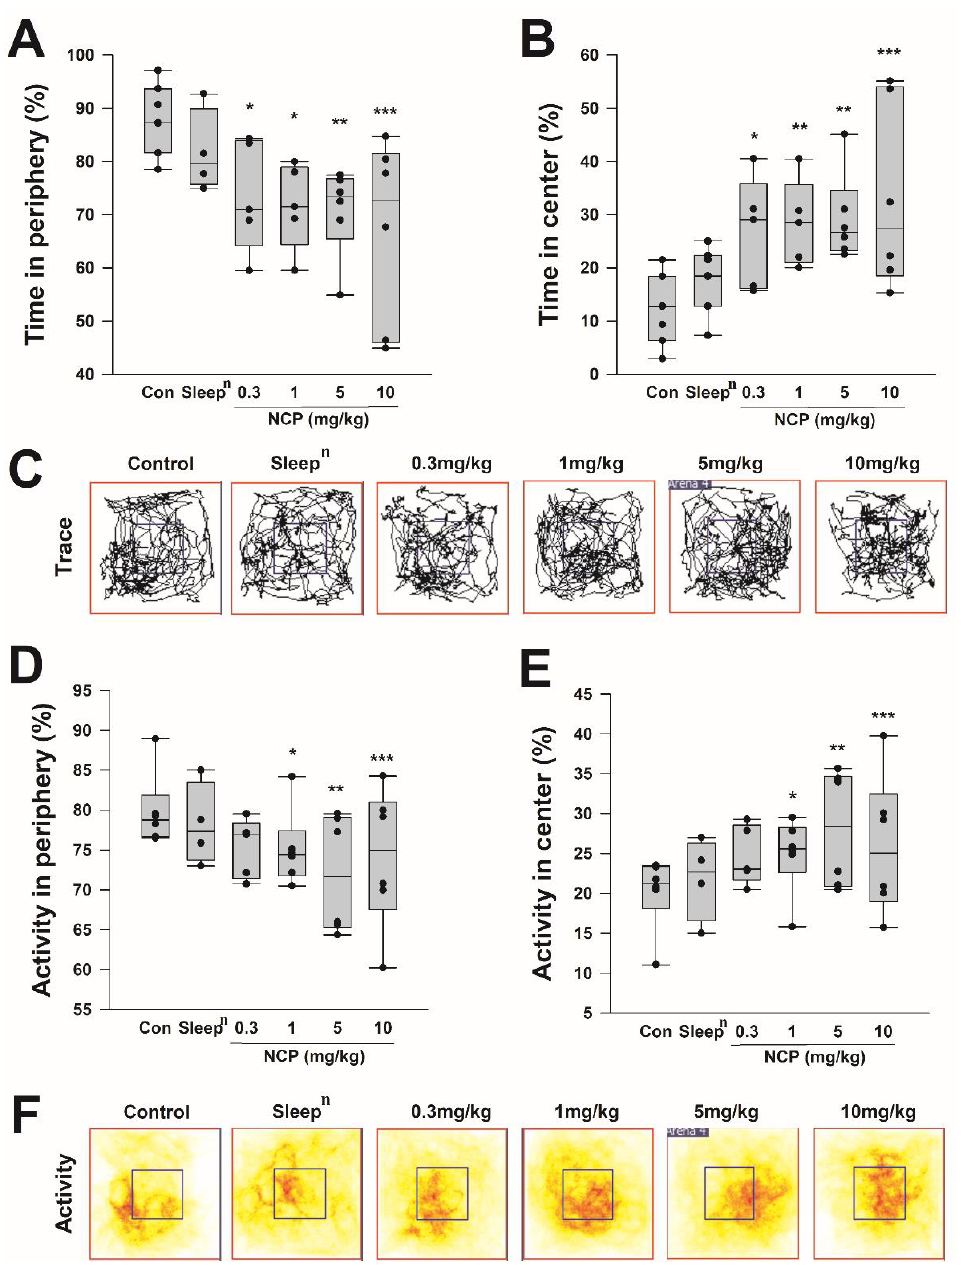
Figure 5. Anxiety and depression level test according to NCP intake in mice. OFT results of mice fed NCP by concentration; Time in periphery percentage ( A ) and time in center percentage ( B ). The entire trace of mice for 6 min ( C ). Activity at the edge ( D ) and activity at the center square ( E ). As a result of displaying the degree of activity in color ( F ), the more red the position, the more movement. Significance was verified through one-way ANOVA, and significance was obtained between groups by post hoc testing using the Fisher- LSD method. Only D and E were calculated with the Student’s t -test. The control group is saline of the same volume. *** p < 0.001, ** p < 0.01, * p < 0.05.